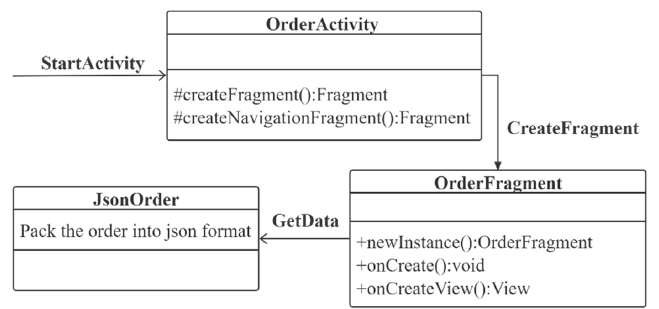
Figure 23. User order class and delivery class relationship.